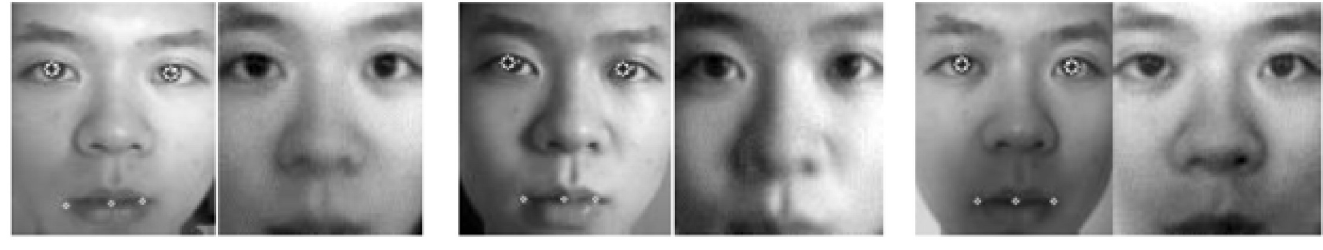
Fig 6. Original images and projected images